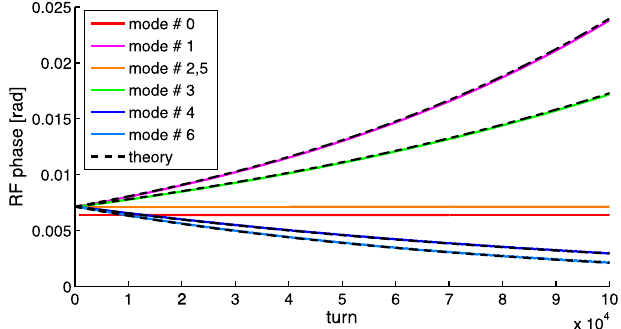
FIG. 4. Amplitude of the multibunch oscillation modes as a function of the number of turns given by M U S I C and compared with the linear theory. The bunches have a Gaussian distribution with rms bunch length equal to 0.21 rad, and the rf voltage is linear.